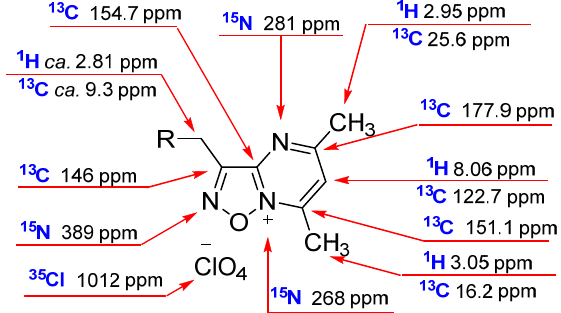
Figure 2. Typical 1 H, 13 C, 15 N, and 35 Cl NMR shifts of 1,2,5-oxadiazolo [2,3- a ]-pyrimidinium perchlo- rates.